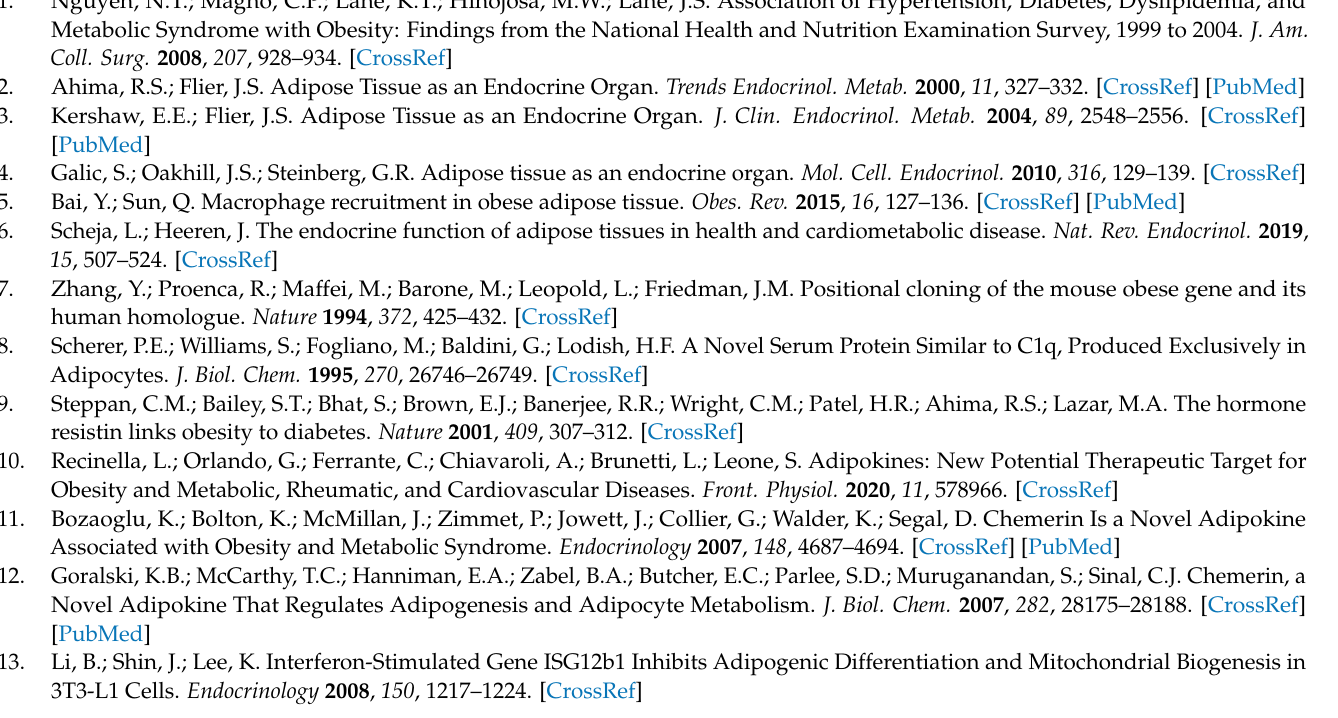
Figure S5: Measurement of cell numbers; Table S1: Primer sequences for real-time PCR and cloning; Table S2: Microarray-based mouse transcriptome dataset; Table S3: Sample sizes of the GTEx data for human tissues. Table S4: RNA-seq analysis of 3T3-L1 cells with or without CHRDL1